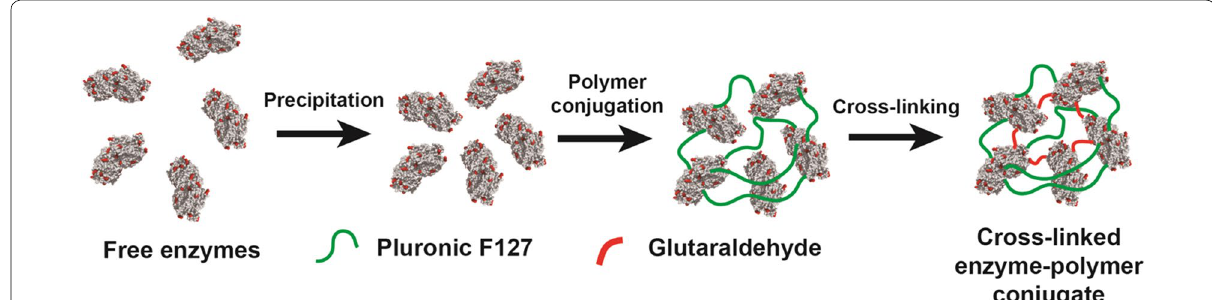
Fig. 1 Schematic diagram of preparing CLEPC. The red dots on the surface of the free enzyme Po OPH M9 represent the lysine residues that are cross‑linked by